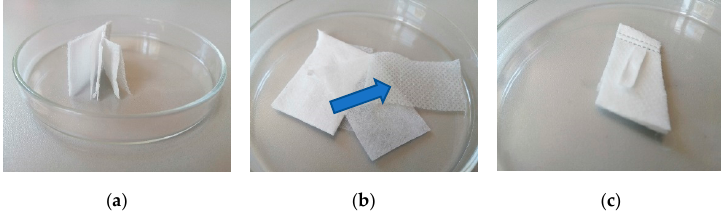
Figure 6. Fragment of a protective mask separated into layers ( a ); additional stiffening layer of the face mask ( b ); an indicator strip located on the surface of the mask fragment ( c ).